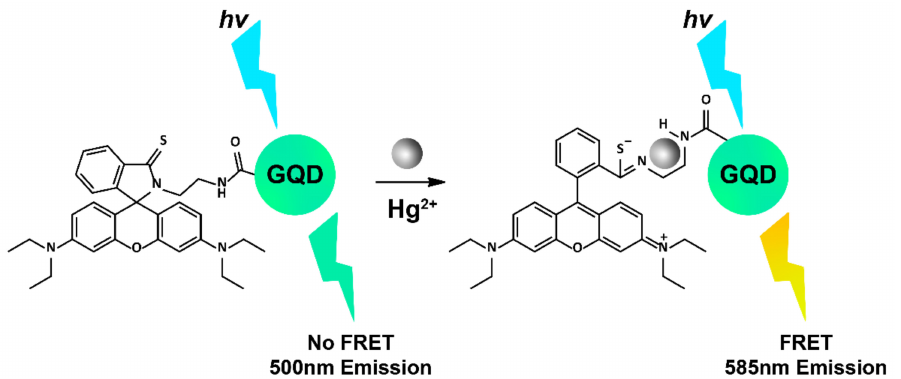
Figure 5. Proposed FRET mechanism of rhodamine-GQDs detecting Hg 2+ . Image adapted with permission [224]. Copyright 2015 Elsevier.